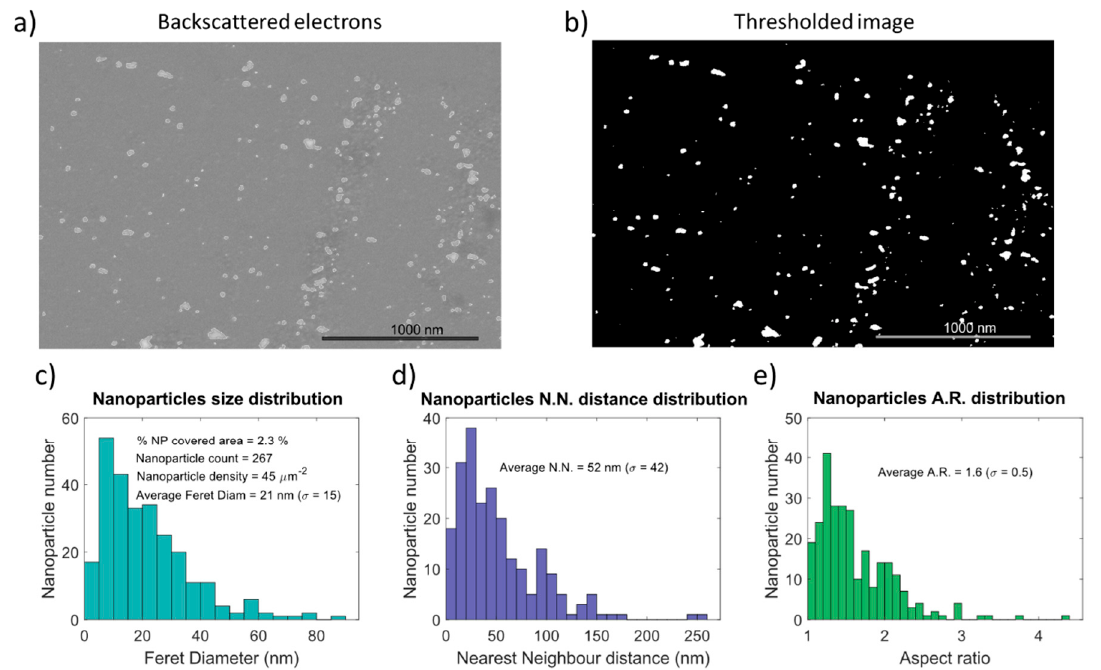
Figure 4. Nanoparticle distribution analysis: ( a ) Shows the top-view SEM micrograph with atomic weight contrast, and ( b ) depicts the processed and thresholded micrographs evidencing the Au nanoparticles. Distribution histograms are also displayed in ( c ) for nanoparticles Feret diameter, ( d ) for nearest neighbor distance, and ( e ) for aspect ratio.